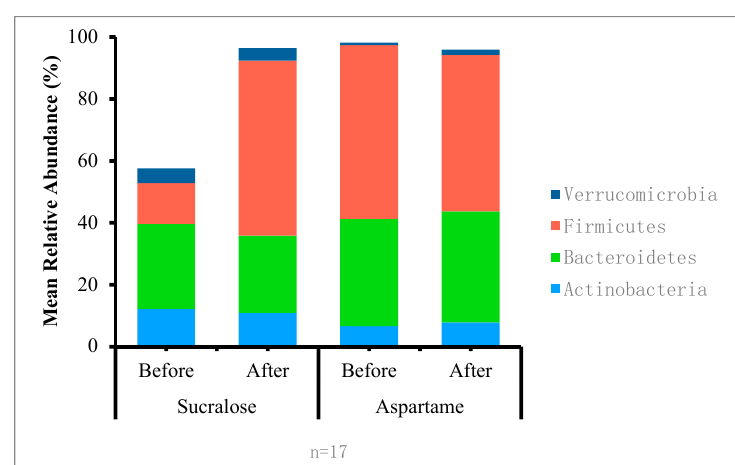
Figure 3. Mean relative abundance of the four dominant microbiota phyla of the human gut by treatment group before and after the administration of aspartame or sucralose drinks.